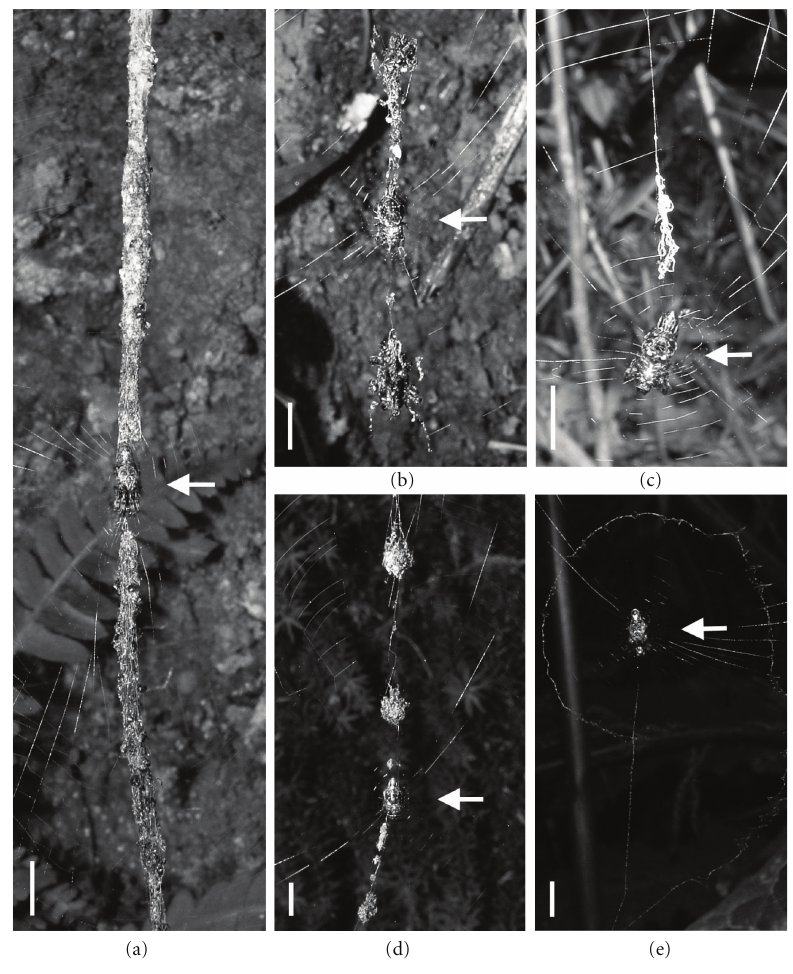
Figure 1: Decoration patterns in C. morretes and C. fililineata webs. (a) Linear detritus structure, (b) complex type with a linear segment and a blob resembling a large spider, (c) linear silk structure, (d) blobs of detritus forming a linear discontinuous structure, and (e) silk spiral. The arrows indicate the position occupied by the spider. Scales: